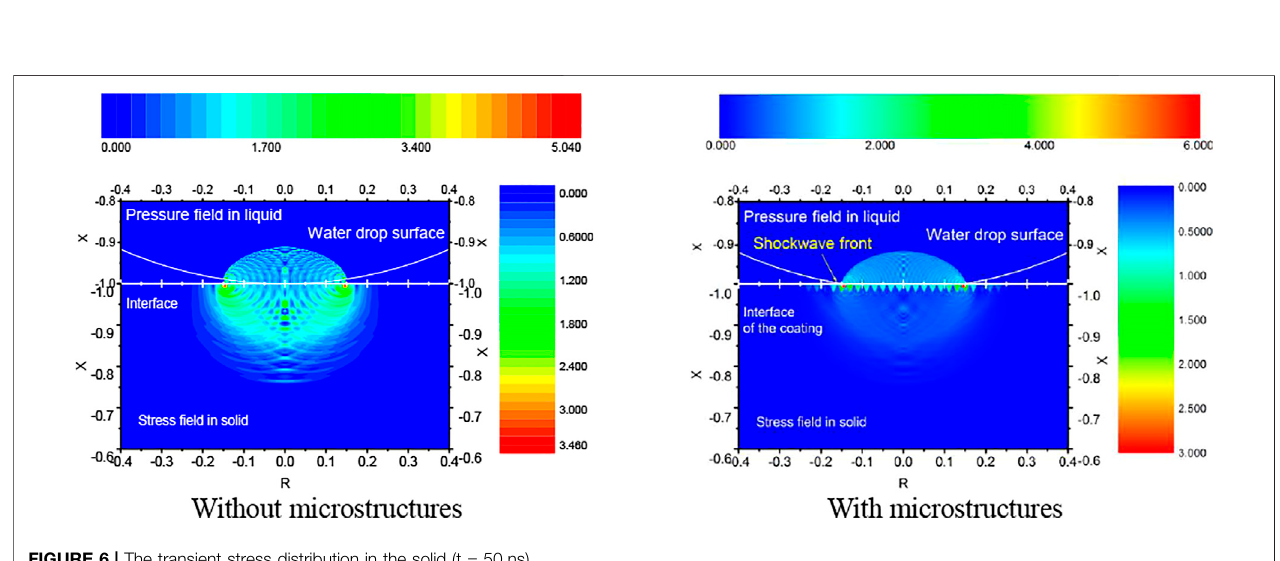
FIGURE 6 | The transient stress distribution in the solid (t = 50 ns).